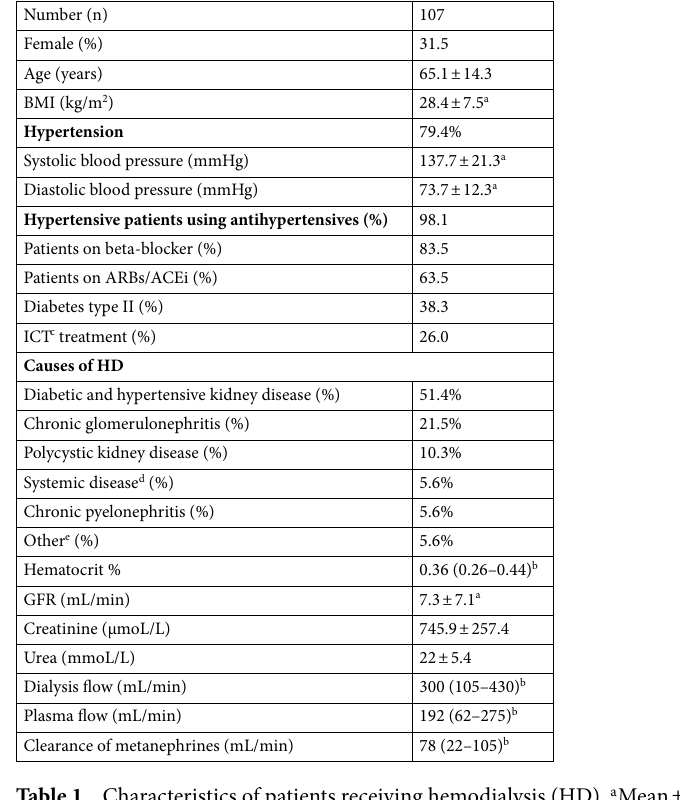
Table 1. Characteristics of patients receiving hemodialysis (HD). a Mean ± standard deviation. b Median-range. c ICT intensified insulin treatment. d Systemic disease: HUS, amyloidosis, multiple myelom, lupus, vasculitis. e Other: toxicity, medication, kidney tumor, hepatocardiorenal